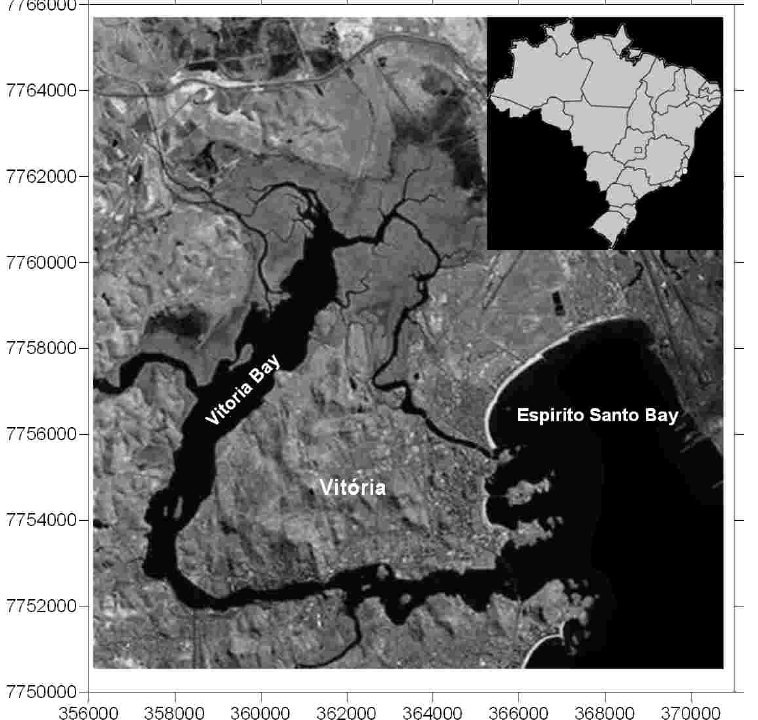
Fig. 1 – Location of the study area (Landsat image source: